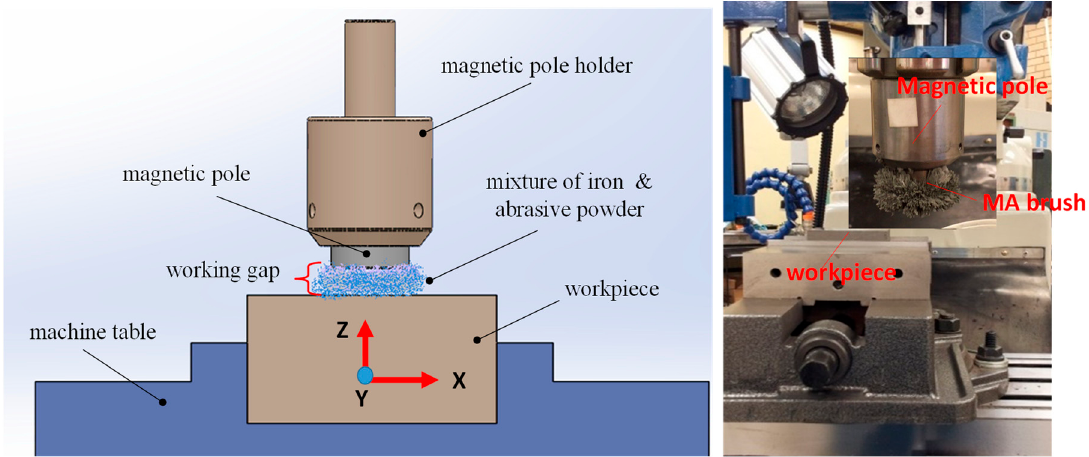
Figure 3. Schematic of magnetic abrasive finishing ( left ) and its experimental set-up ( right